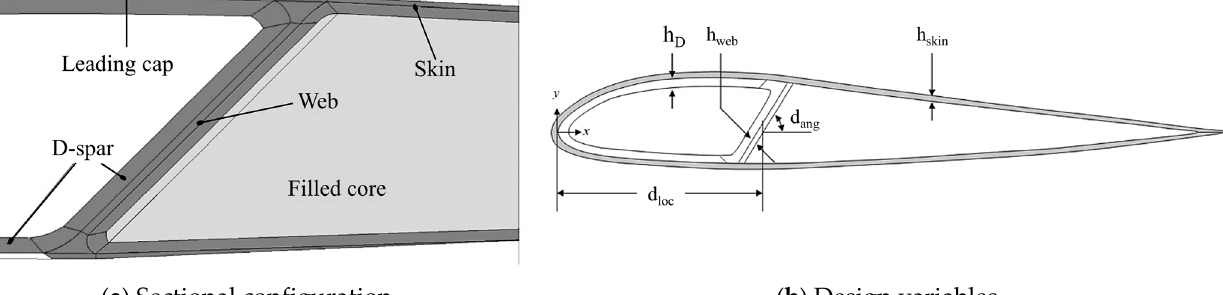
Figure 6. Structure design configuration and design variables of rotor blade.